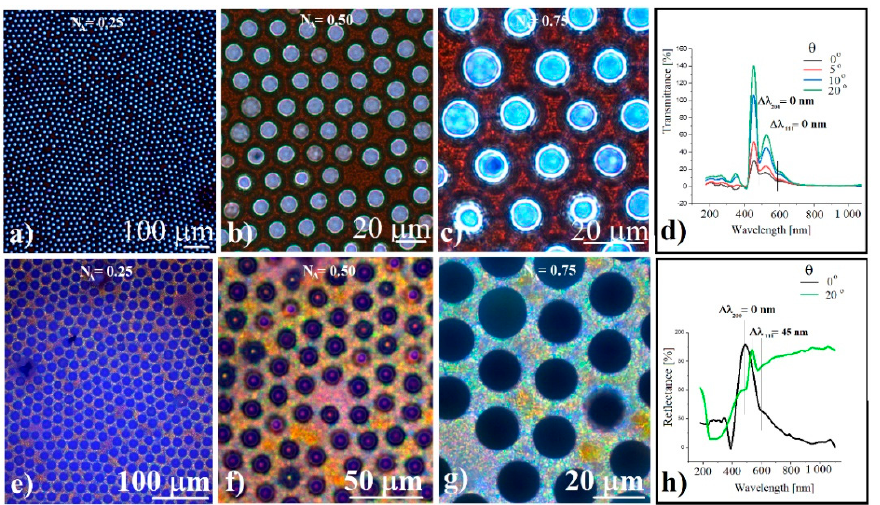
Figure 4. ( a – c ) Transmission optical microscopy images of silica spheres concavity array for different focusing and numerical apertures; ( d ) angle-resolved transmittance of silica spheres ordered concavi- ties; ( e – g ) reflection optical microscopy images of silica spheres concavity array for different